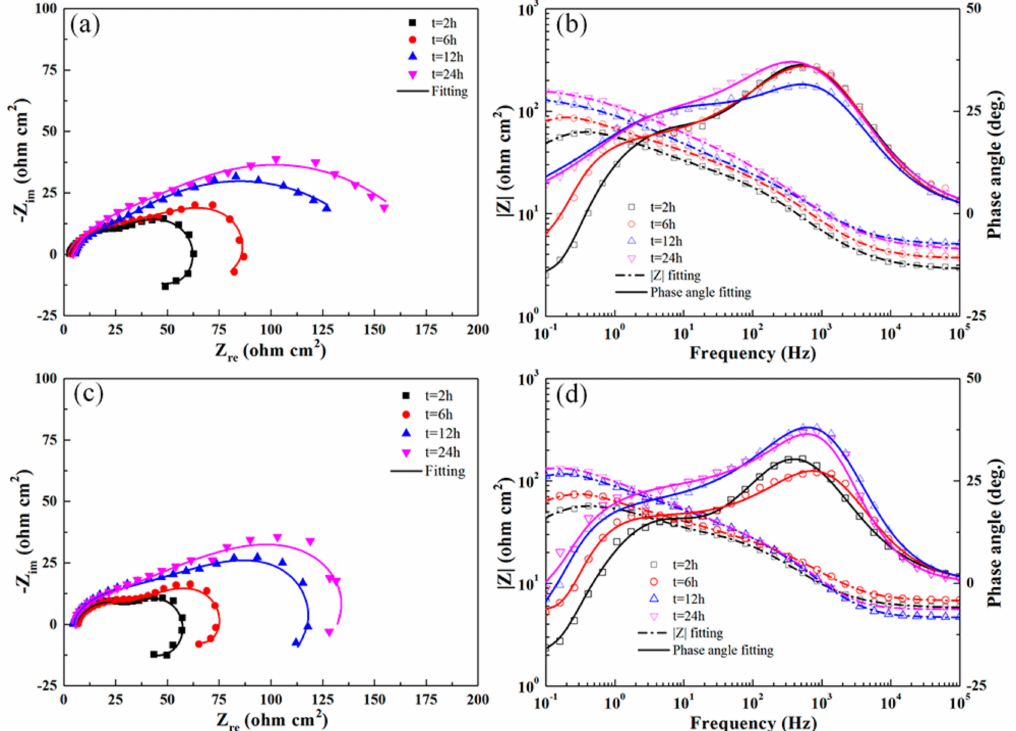
Figure 10. Nyquist ( a , c ) and Bode ( b , d ) plots obtained for UR1 and UR1-R samples immersed for di ff erent times in the test solution at